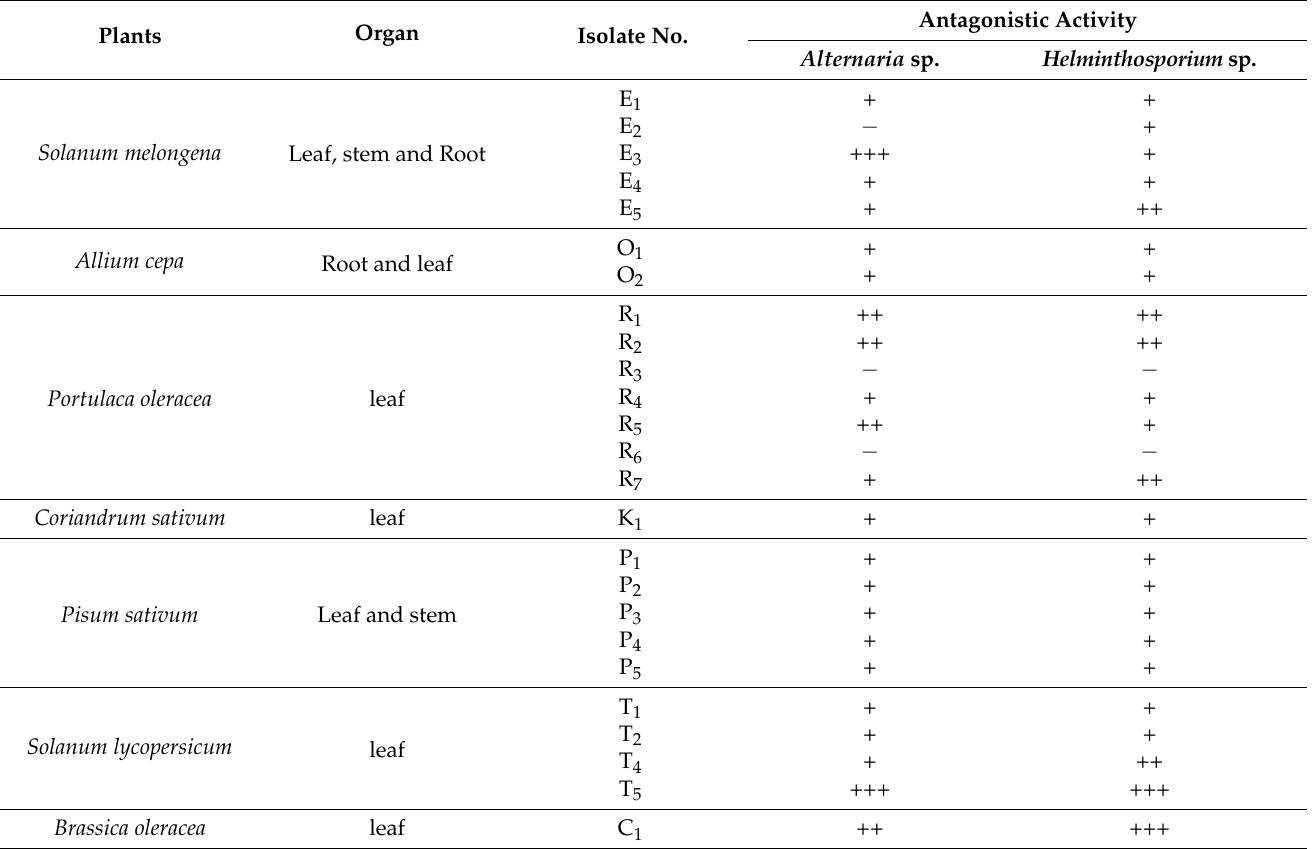
Table 1. Endophytic bacterial isolates from various crop plants were isolated and tested for inhibitory activity against Alternaria sp. and Helminthosporium sp. using a dual culture technique. Organ Isolate No. Alternaria